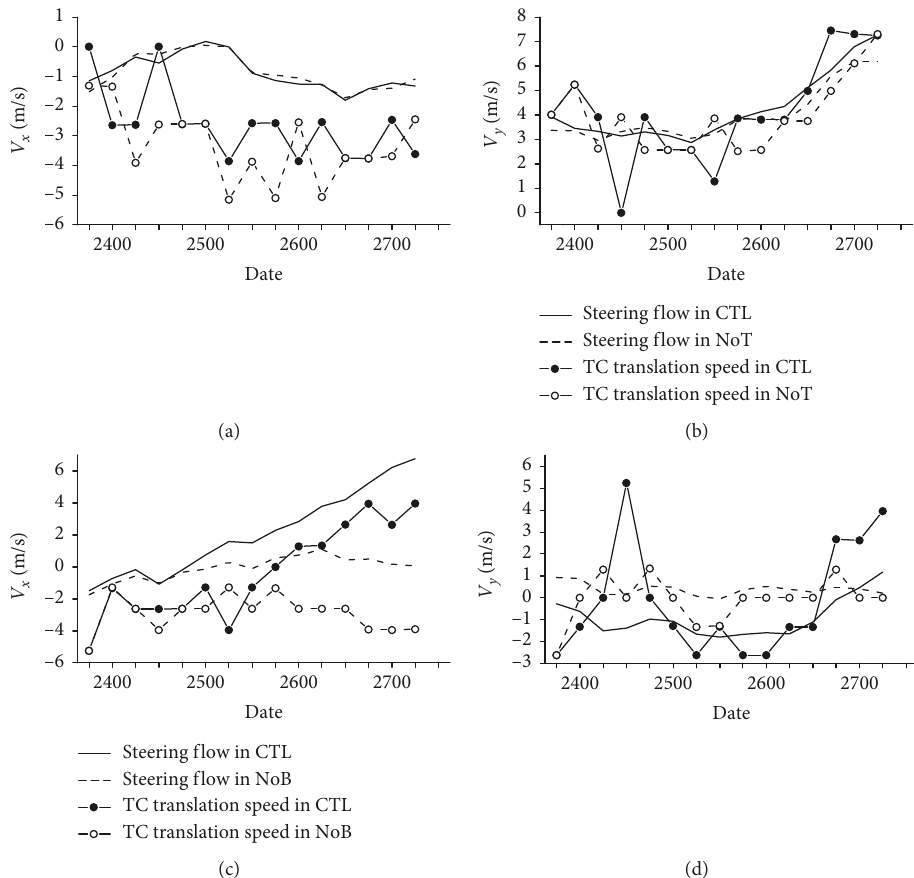
Figure 7: Time series of the zonal component (a, c) and the meridional component (b, d) of the environmental steering flow (solid line: CTL experiment; dash line: sensitivity experiments) and the translation speed (black circle line: CTL experiment; white circle line: sensitivity experiments) of Bolaven (a, b) Tembin and (c, d) from 1800 UTC 23 August to 1200 UTC 27 August (unit: m s